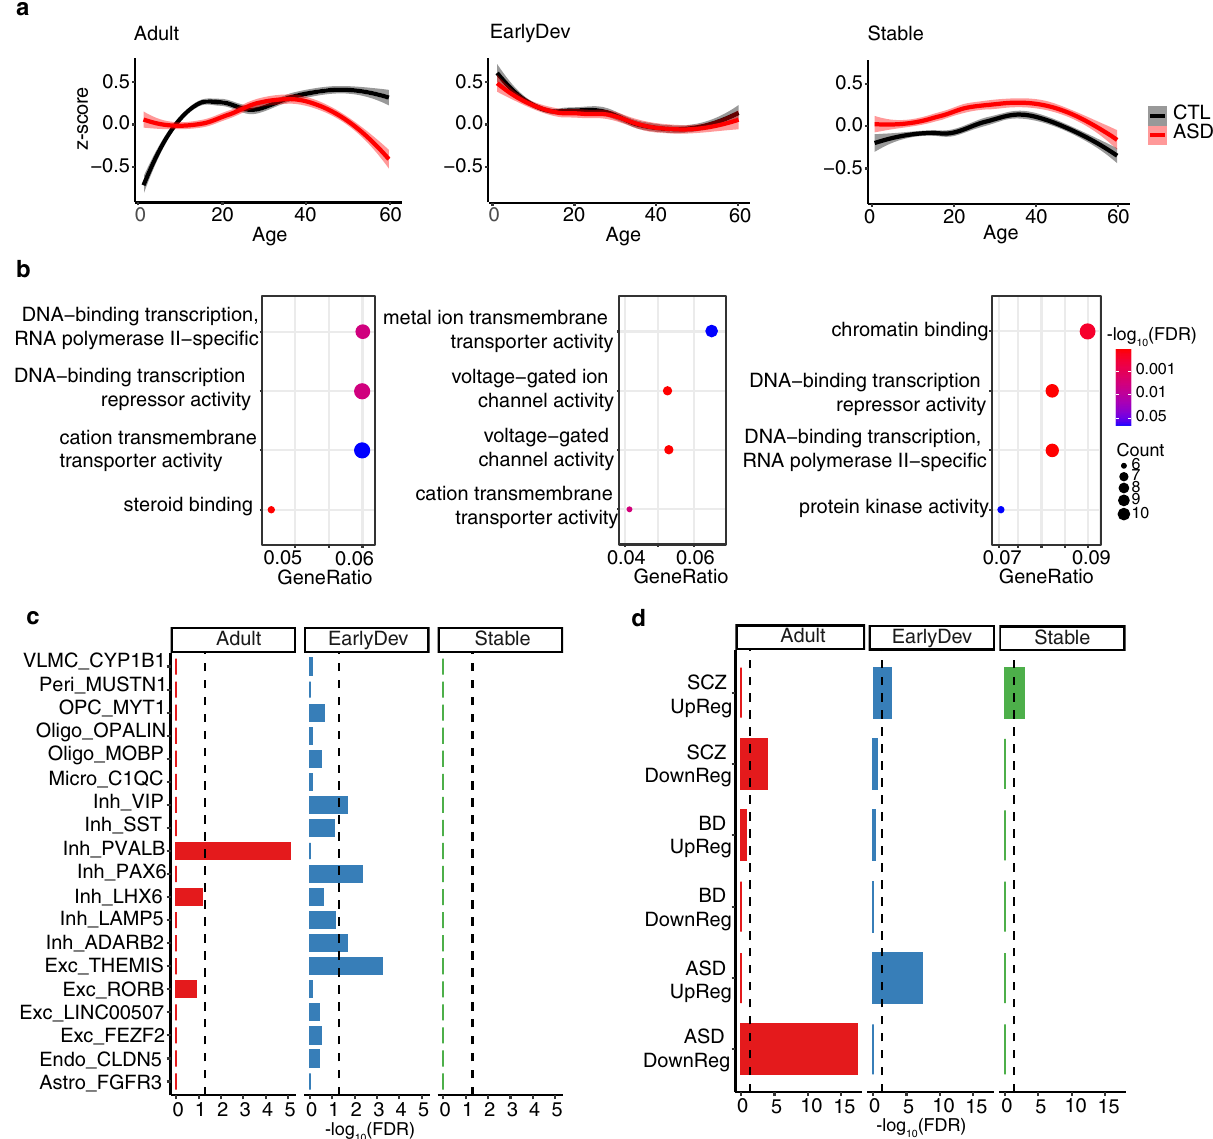
Fig. 4 Differentially correlated genes in individuals with ASD are important for brain development. a The 415 genes were clustered in three developmental time groups: adult (Adult), early development (EarlyDev), stable (Stable). X -axis represents developmental time. Y -axis represents the expression based on human brain developmental time. Loess regression with con fi dence intervals depicts the overall distribution. Smooth curves are shown with 95% con fi dence bands with relative trendlines. b Bubblechart representing the functional enrichment for modules associated with developmental time. Y -axis corresponds to the odds ratio, X -axis corresponds to the − log 10 (FDR). c Bar plot depicting the − log 10 (FDR) of the Fisher ’ s exact test enrichment between developmental clusters and cell-type markers ( Y -axis) from single-nuclei RNA-seq from multiple brain regions ( “ Methods ” ). VLMC = vascular leptomeningeal cell, Peri = pericytes, OPC = oligodendrocyte precursor cell, Micro = microglia, Inh = inhibitory neuron, Exc = excitatory neuron, Endo = endothelial cell, Astro = astrocyte. d Bar plot depicting the − log 10 (FDR) of the Fisher ’ s exact test enrichment between developmental clusters and genes differentially regulated in ASD, schizophrenia (SCZ), and bipolar disorder (BD) ( Y -axis) from an independent study ( “ Methods ”